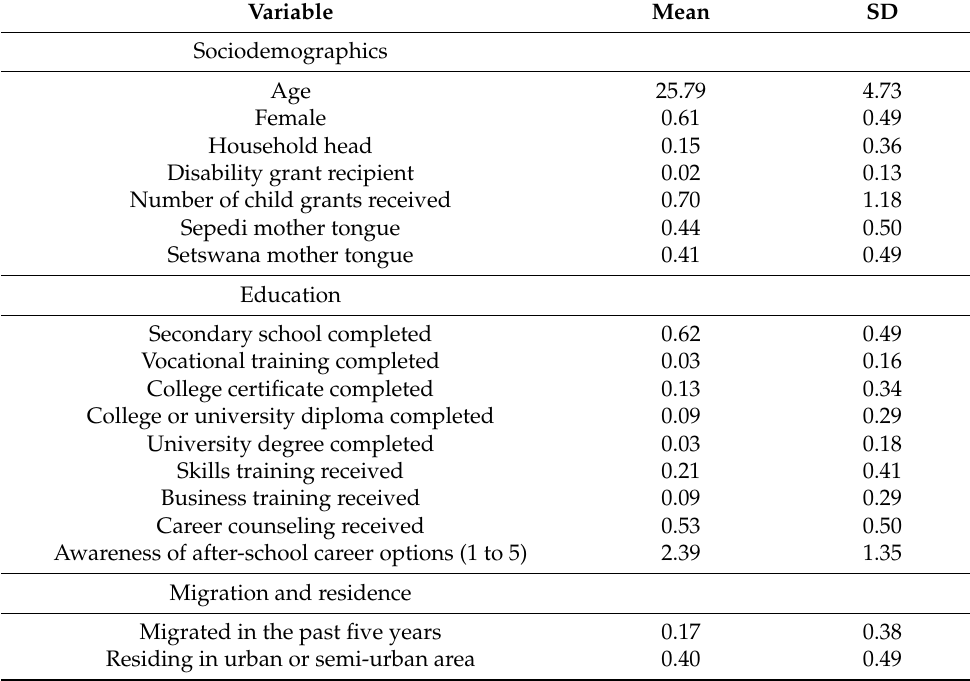
Table 1. Descriptive